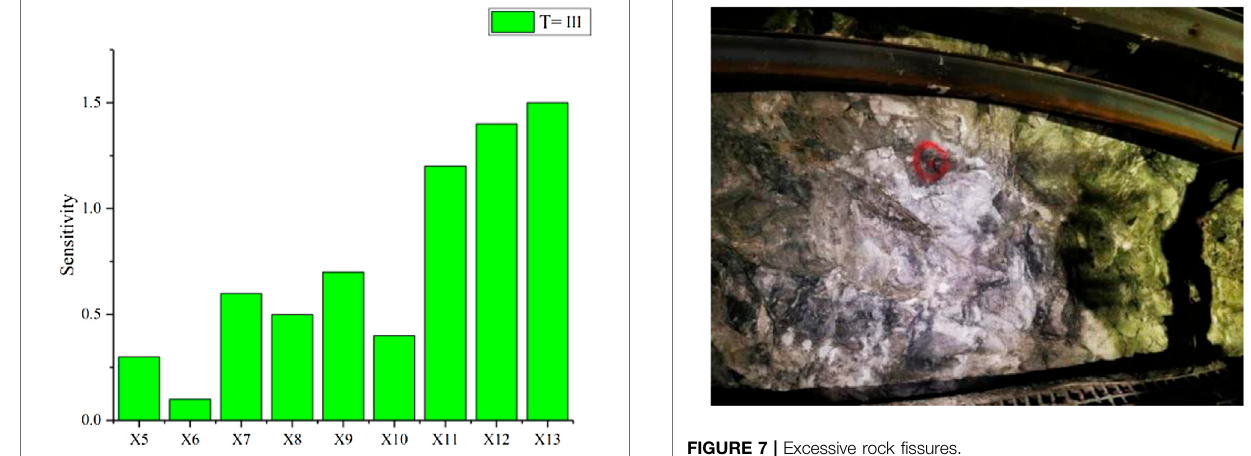
FIGURE 7 | Excessive rock fi ssures.